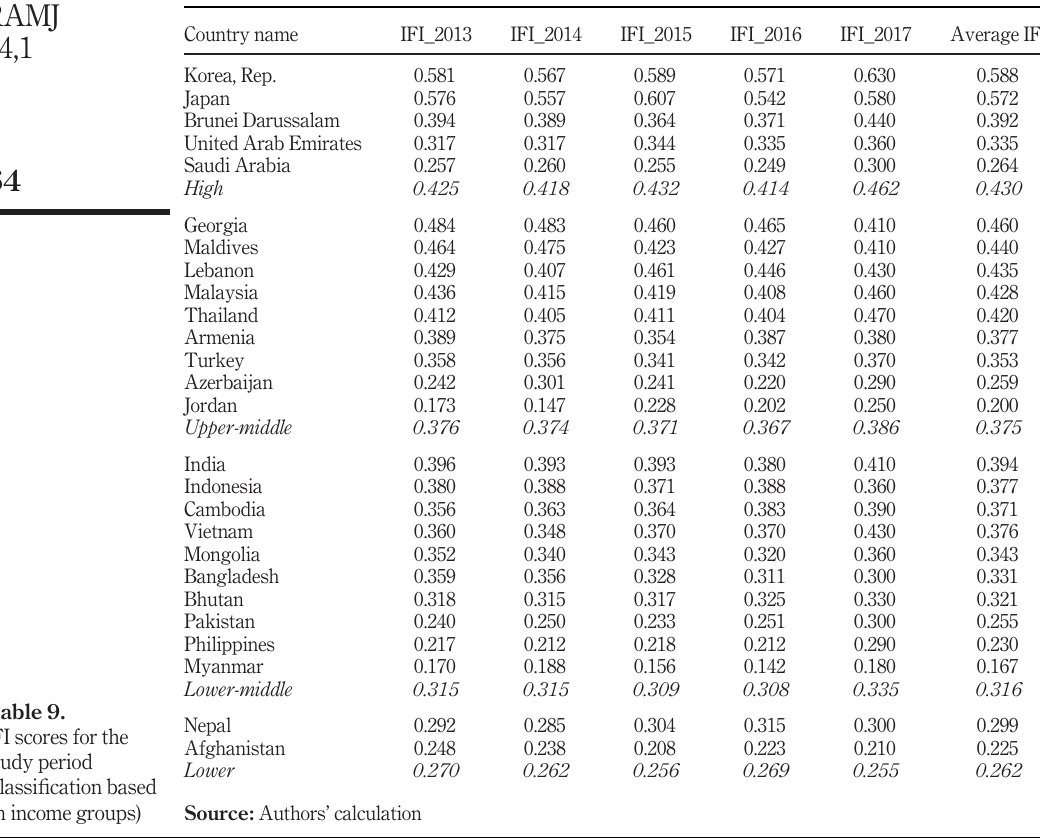
Table 9. IFI scores for the study period (classi fi cation based on income groups)